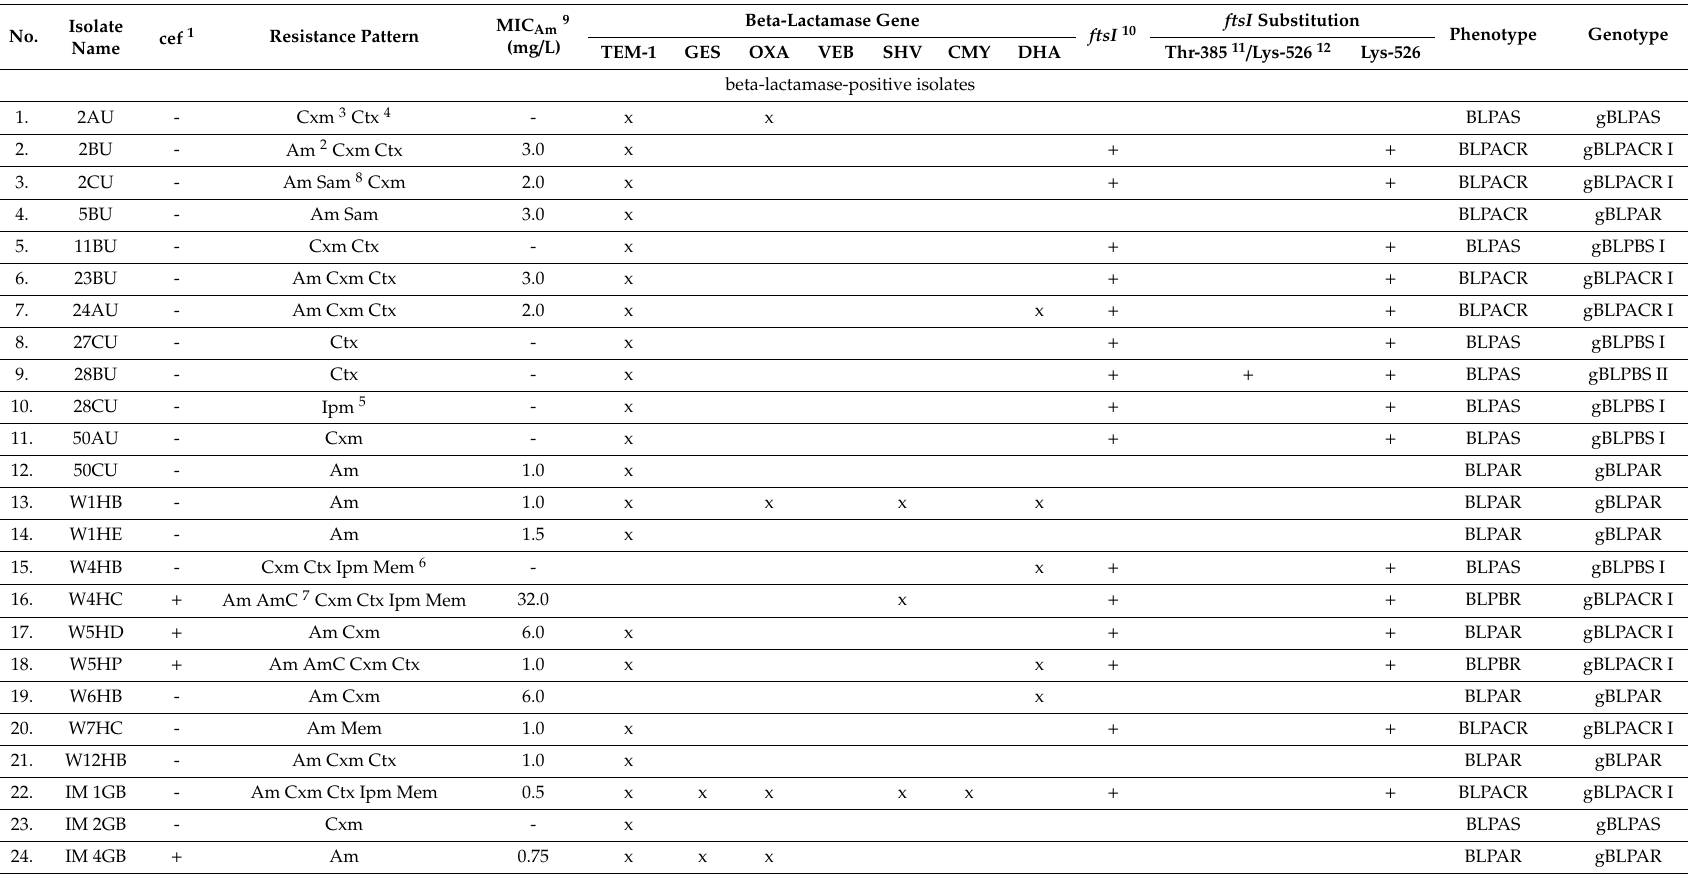
Table 4. Distribution of resistance genes of the 57 Haemophilus parainfluenzae isolates and resistance patterns to seven beta-lactam